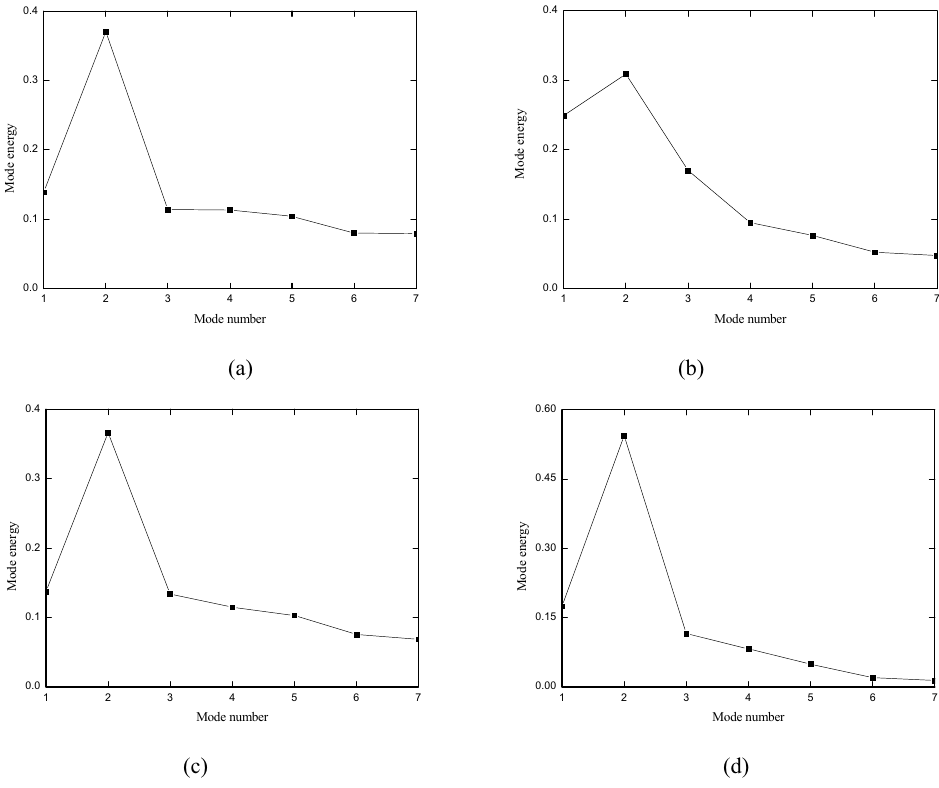
Fig. 5. IMF Energy of four kinds of signals (a) No flaw (b) Delamination (c) Debonding (d)